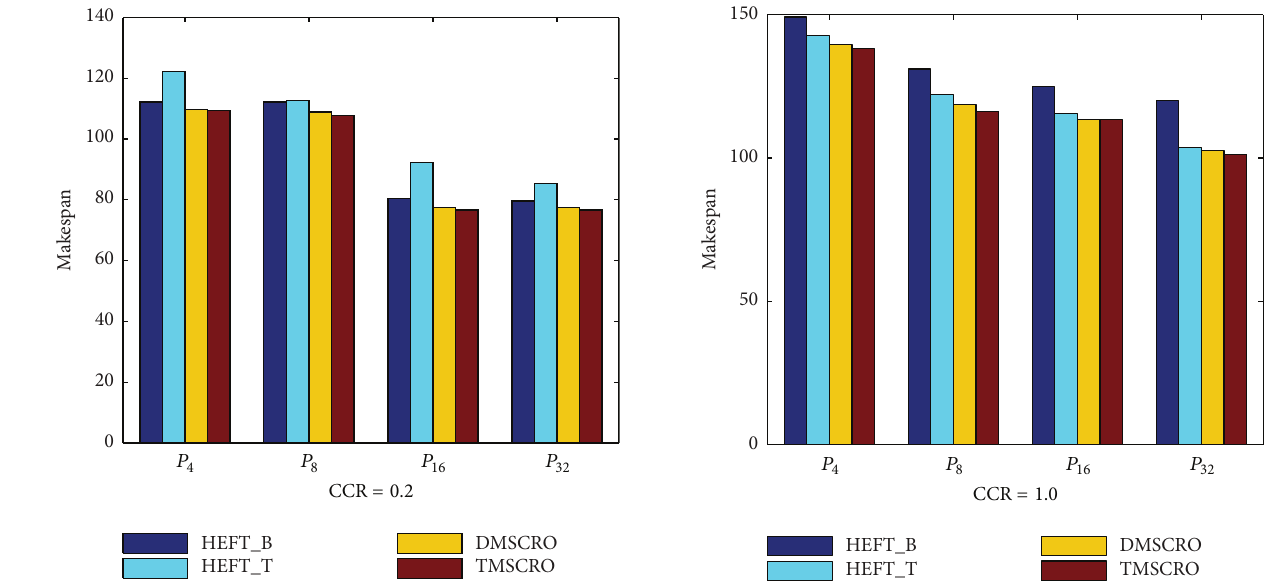
Figure 17: Average makespan for the molecular dynamics code.